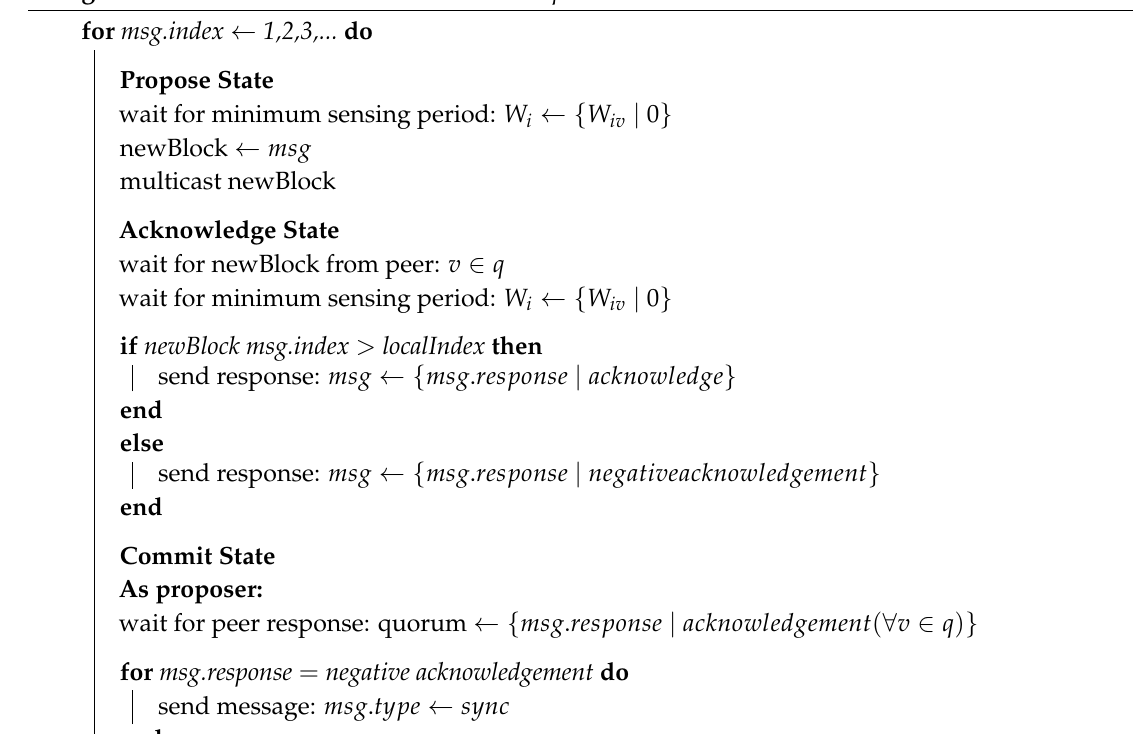
Algorithm 2: Conte Consensus for node v ∈